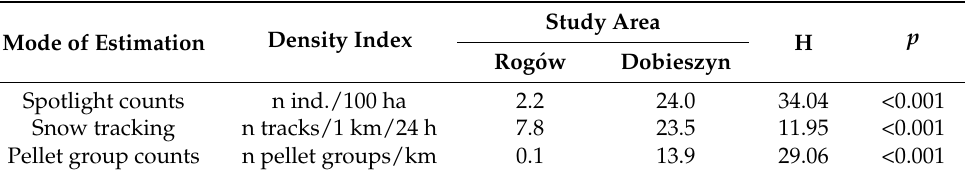
Table 1. Comparison of indices of brown hare densities between the study area (Rogów) and a ref- erence area placed in central Poland (Dobieszyn) in the past decades (Table S1). Values of the Krus- kal–Wallis test (H) and p -values are given.